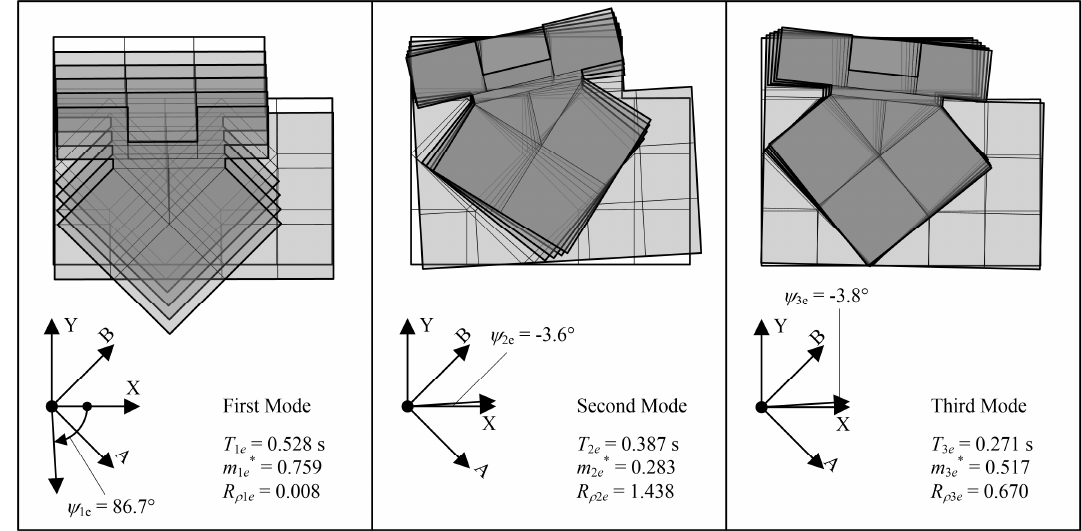
Figure 12. The shape of the first three natural modes of the building model in the elastic range.